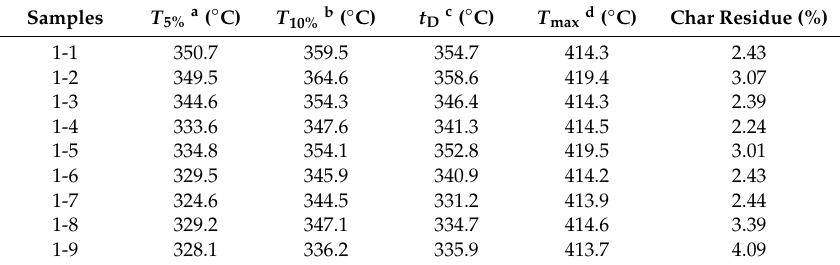
Figure 13. TGA and DTA curves of polyester-based TPUs. ( a ) TGA; ( b ) DTA. Table 7. Degradation temperature and char residue of polyester-based TPUs.